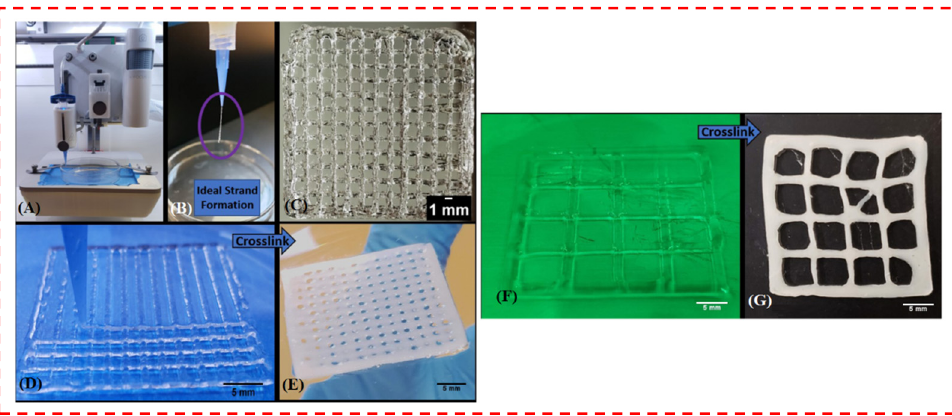
Figure 12. Bioprinting of scaffolds using chitosan (CS)-polyethylene oxide-glycerol phosphate (CPG) gel. ( A ) The bioprinting system, consisting of a temperature-controlled printhead and printbed. ( B ) A printed structure showing the ability of the gel to form ideal. ( C ) Printed scaffold with square pores. Scaffolds ( D , F ) before thermal gelation, and ( E , G ) after thermal crosslinking at 37 °C for approximately 770 s. Scale bars = 5 mm [130].